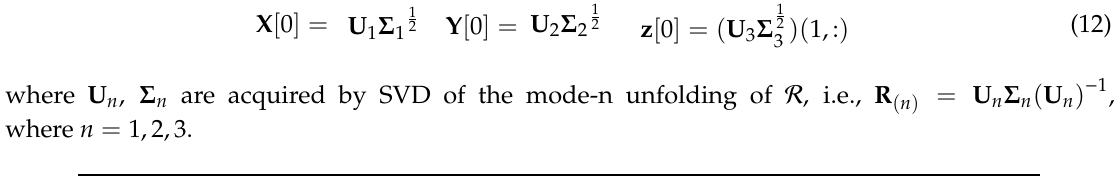
Algorithm 1 OLCP-InSAR for tensor model